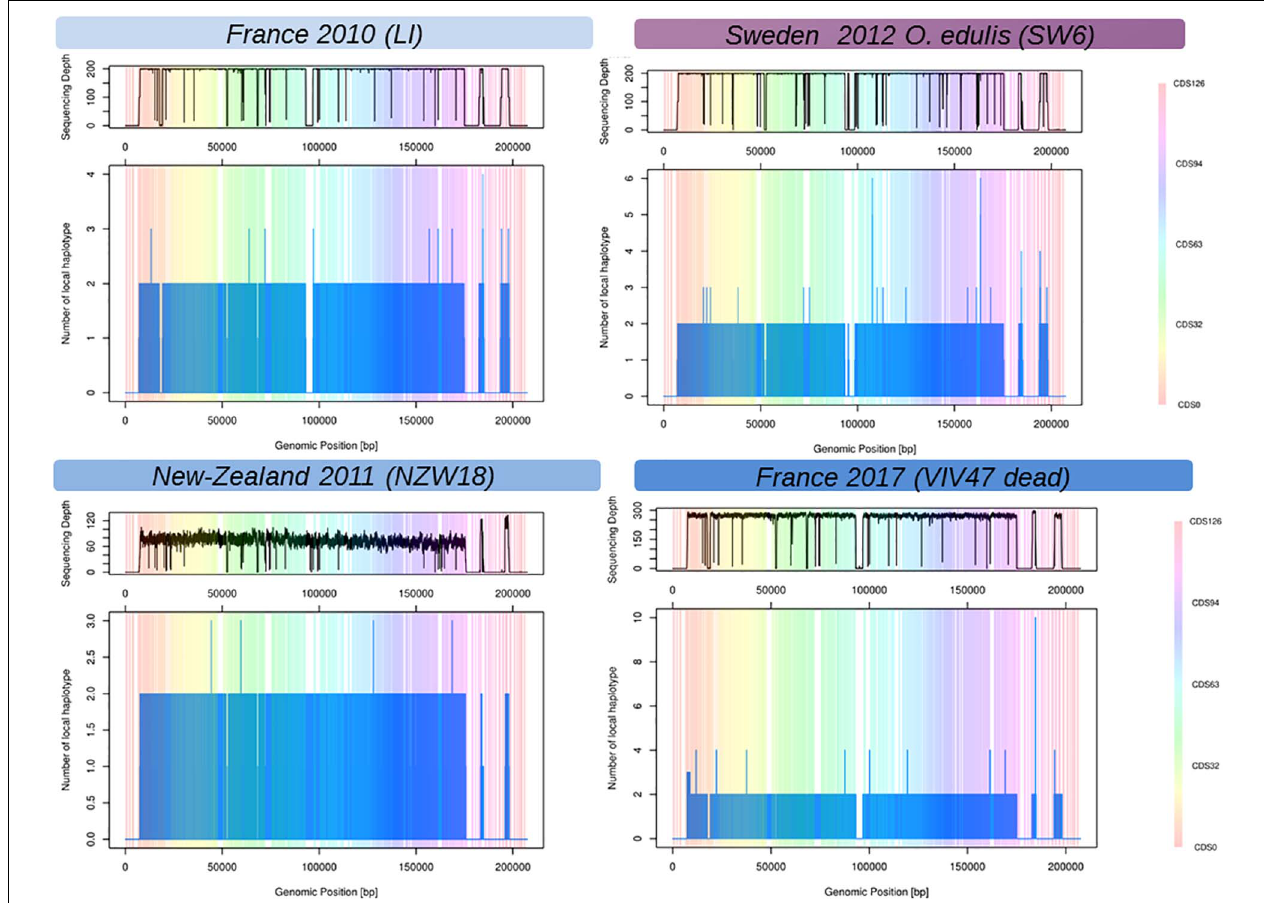
FIGURE 2 | Reconstructed local viral haplotypes for four samples using Shorah with amplicon mode (Zagordi et al., 2011). The X-axis represents the genomic position within the reference viral genome (Davison et al., 2005). The Y-axis is the number of reconstructed viral haplotypes on the focal genomic position. The vertical-colored bands represent the span of the coding DNA sequence (CDS) of the reference viral genome (Davison et al., 2005), one color represents one CDS numbered from 1 to 127. The top panels above the plots represent the coverage depth across the viral genome. Low or no sequencing depth on a genomic region could be interpreted as genomic deletion on the considered